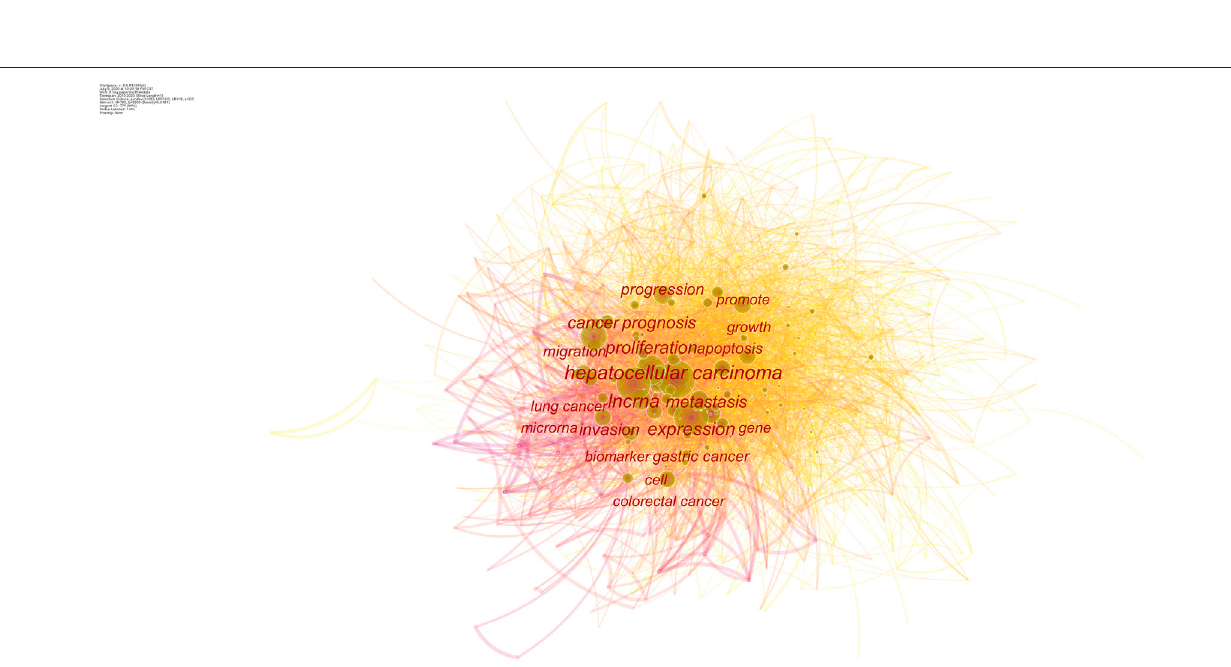
Frontiers in Genetics |